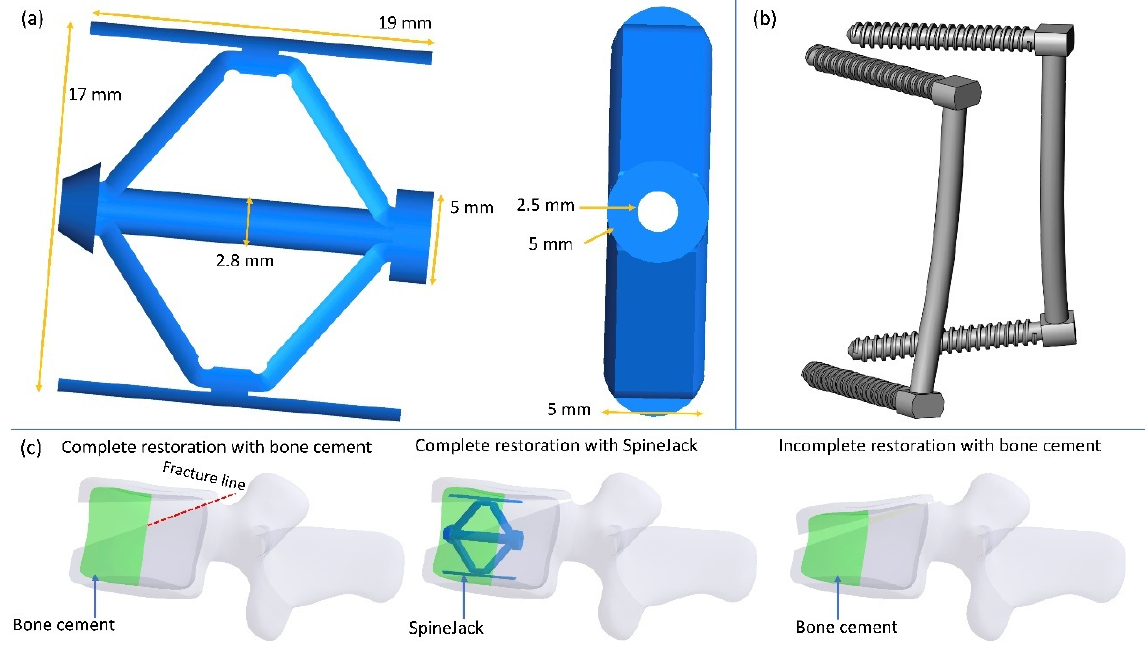
Figure 2. The ( a ) SpineJack, ( b ) PI, and ( c ) fractured vertebral body used in this study. The expansion height, plate length, insertion diameter, and blocking tube diameter were 17, 19, 5, and 2.5 mm, respectively. The outer diameter of the pedicle screws and the rod were both set to 6.5 mm, and the length of the rod was set to 50 mm. The geometry of the pedicle screw was defined according to the commercial product. In addition to the models without body height loss, incomplete restoration of the body height of the lumbar spine was also considered. A wedge-shaped bone loss of 20% at the anterior portion of the vertebral height has been developed [2,12]. The anterior cortex was removed in the same manner as in the model with complete body restoration. In total, an intact lumbar spine and six different fractured and augmentation lumbar models were developed (Figure 1), including complete restoration of the vertebral body augmented with bone cement (CC), bone cement along with PI (CCPI), bone cement along with the SpineJack (CCSJ), bone cement along with the SpineJack and PI (CCSJPI), incom- plete restoration of the vertebral body augmented with bone cement (ICC), and bone ce- ment along with PI (ICCPI). 2.2. Finite Element Model The solid model was imported into ANSYS Workbench 2019 R3 for mesh generation and further simulations. Quadratic elements (solid 187) were used to mesh the entire lum- bar model. The length of the element edge was set to 3 mm globally. The mesh density of the intervertebral disk was locally refined by reducing the length of the element edge to 1 mm with the command “sizing” in ANSYS Workbench. The length of the element edge for the SpineJack and pedicel screw and the bone area surrounding the implants were set to 1 mm. The facet joints were set to a frictional surface to surface contact with a coefficient of 0.1 [15]. The contact behaviors between the implants (SpineJack and pedicel screw), bone, and bone cement as well as between the pedicle screw and the metallic rod were set to bond. The spinal ligaments, namely, the anterior longitudinal ligament, posterior longitu- dinal ligament, supraspinous ligament, interspinous ligament, intertransverse ligament, ligamentum flavum, and joint capsule, were represented by tension-only springs. The lo- cations of the ligaments were defined according to their origin and insertion sites. The